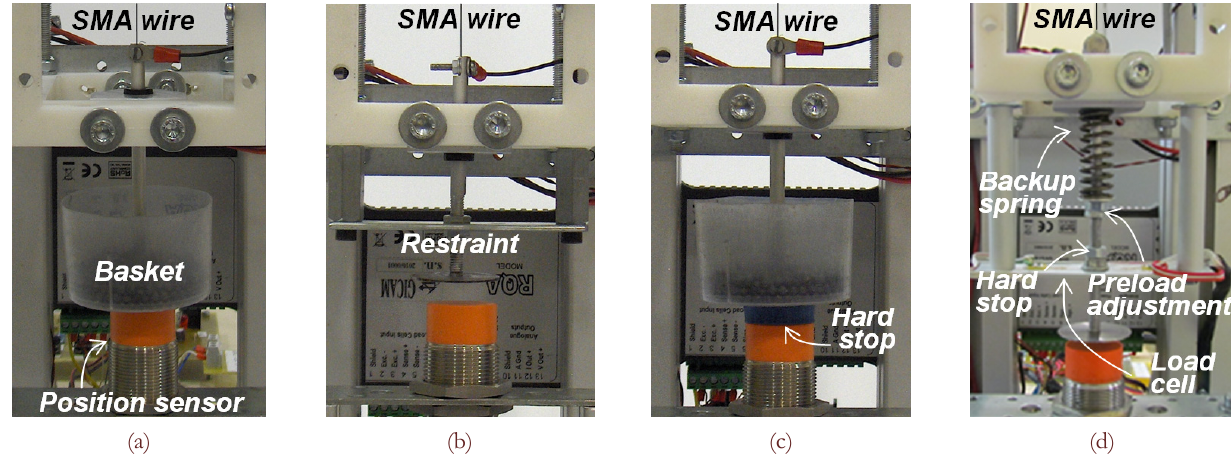
Figure 2: Details of the apparatus used to apply the four test conditions of Fig. 1: (a) constant-stress; (b) constant-strain; (c) constant- stress with limited maximum strain; (d) linear stress-strain